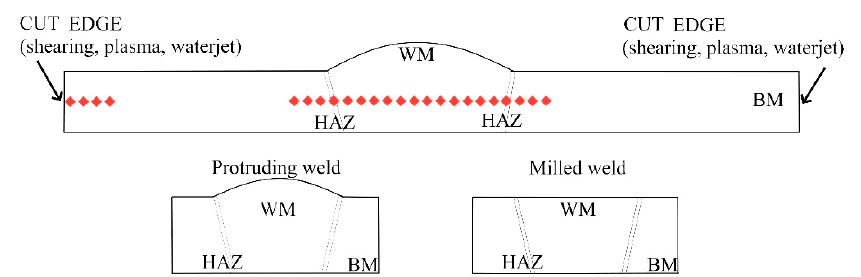
Figure 2. Drawing of micro-hardness measures path (red-diamond) along with BM, HAZ and WM and near the edges. Representation of the weld in the protruded and in the milled state.